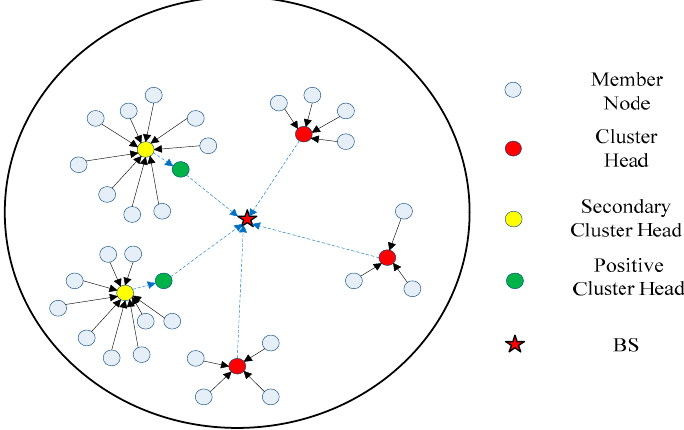
Figure 7. WSN clustering topology (D-CHs division of energy balance strategy in large clusters).